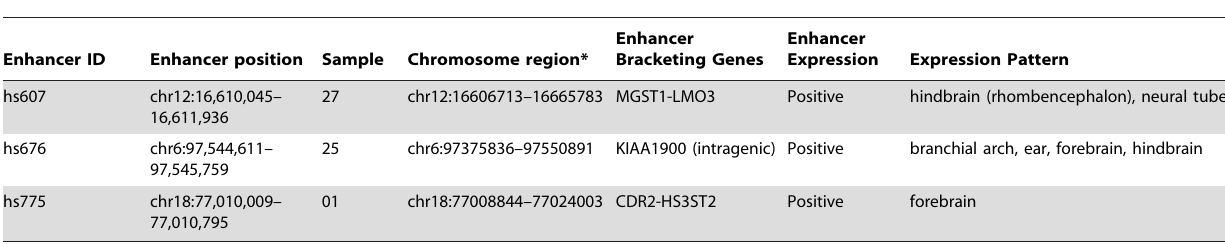
Table 4. VISTA enhancer loci deleted in our patients.